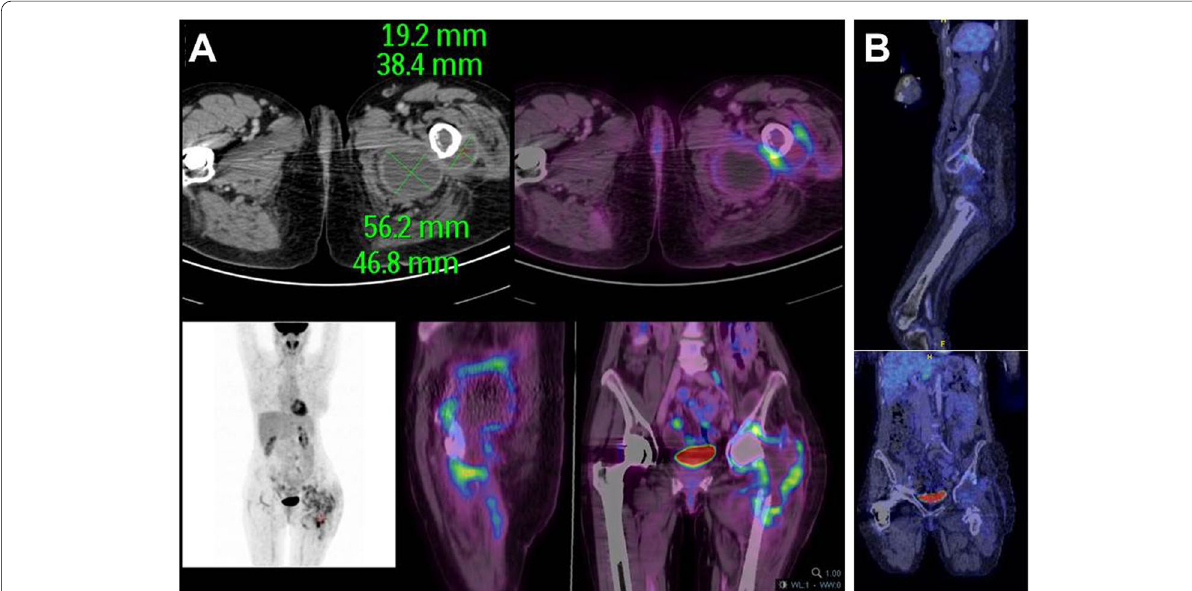
Fig. 3 Positron emission tomography/computed tomography (PET-CT) performed ~ 3 months after the prosthesis explantation, showing a large ilio-psoas muscle collection (47 56 mm) communicating with numerous periprosthetic collections of the left hip (panel A ). A second PET-CT was × performed in June 2014, after the third surgical procedures and at ~ 6 month of rifampin and ofloxacin combination therapy, showing no persistent inflammatory process of the left hip and thigh (panel B